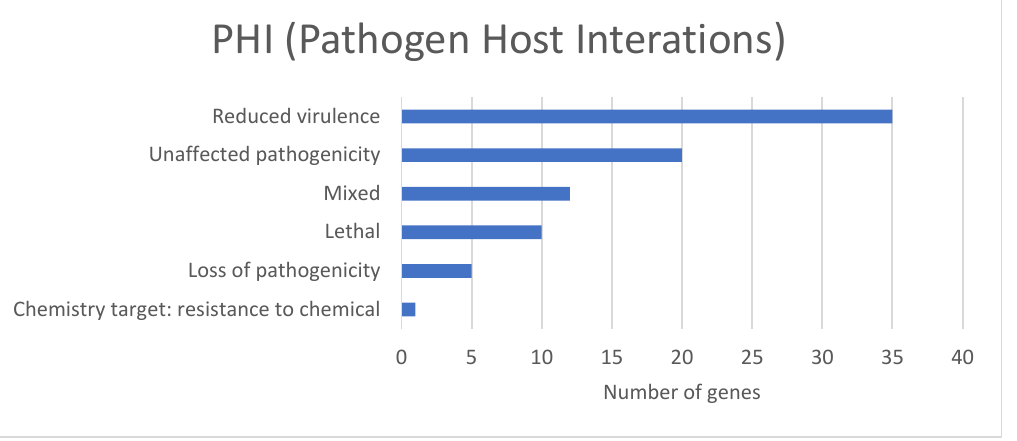
Figure 4. Total of predicted genes of the strain CBS 104.62, that shared significant homology with genes in the pathogen–host interaction (PHI) database.